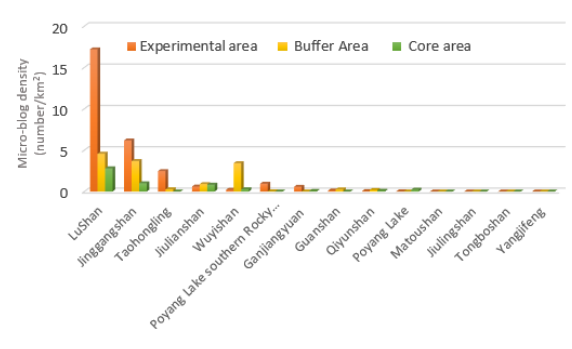
Figure 2. Microblogging density of nature reserves